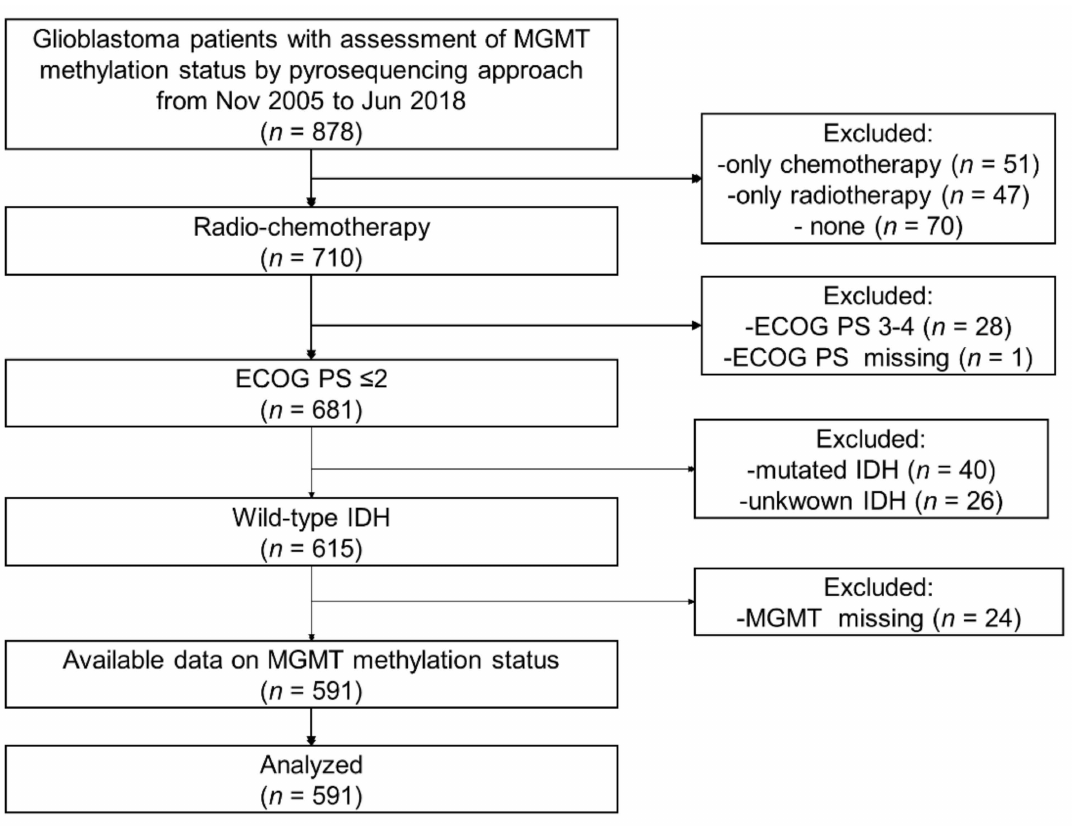
Figure 1. Flow diagram of patient selection. Table 1. Characteristics of glioblastoma patients with assessment of MGMT promoter methylation status by PSQ approach. Data expressed as n (%) or a median (IQR). Data not available in b 2